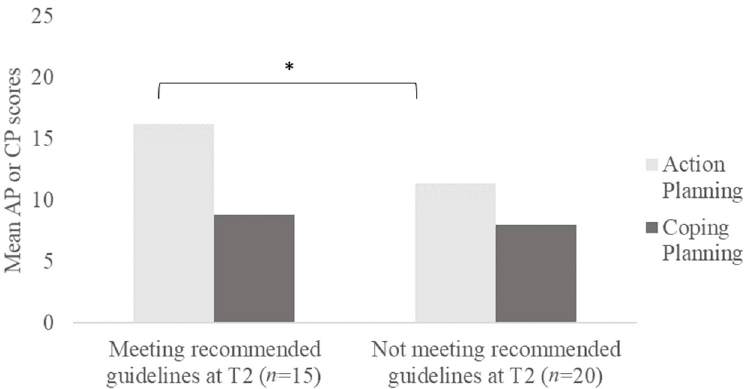
Figure 1. Differences in mean action and coping planning scores for participants who did not meet recommended physical exercise guidelines at time point 1 ( n = 35). Note. * = statistically significant difference at p < 0.05 level.